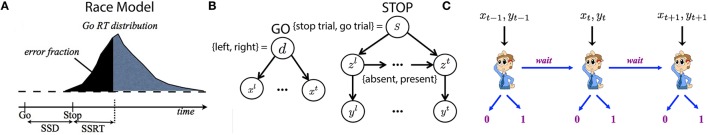
Model illustration. (A) Classical race model for behavior in the stop-signal task. The behavioral outcome (go or stop) is determined by a race between a go and a stop process. The go reaction time has a broad distribution due to noise. The stop process has an average delay known as the stop signal reaction time (SSRT). The stop error rate is the cumulative density of Go RT at SSD + SSRT. The SSRT is thus estimated from data as the difference between the median go RT and the SSD at which 50% stop error is achieved, as SSD+SSRT = median(go RT) implies 50% of stop trials will end in error (the rest in success). (B) Bayesian generative model of iid sampled sensory observations (x1, …, xt, …) conditioned on Go stimulus identity (d = 0 of left, d = 1 for right), and an independent stream of observations (y1, …, yt, …) conditioned on the presence (zt = 1) or absence (zt = 0) of the Stop signal, which has a geometrically distributed onset time when it is a stop trial s = 1 and never appears on a go trial (s = 0). (C) The decision of whether/when to Go, and which Go response to select, are modeled as sequential decision-making, where the subject chooses at each moment whether to select a Go response, or to wait at least one more time point.